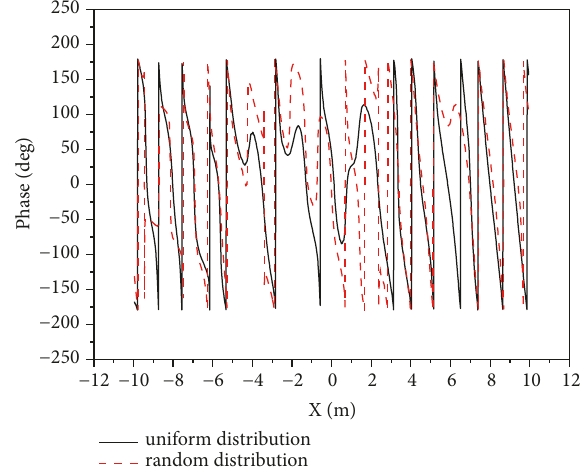
Figure 4: Phase of near scattering field from the multilayers vegetation with uniform distribution and random